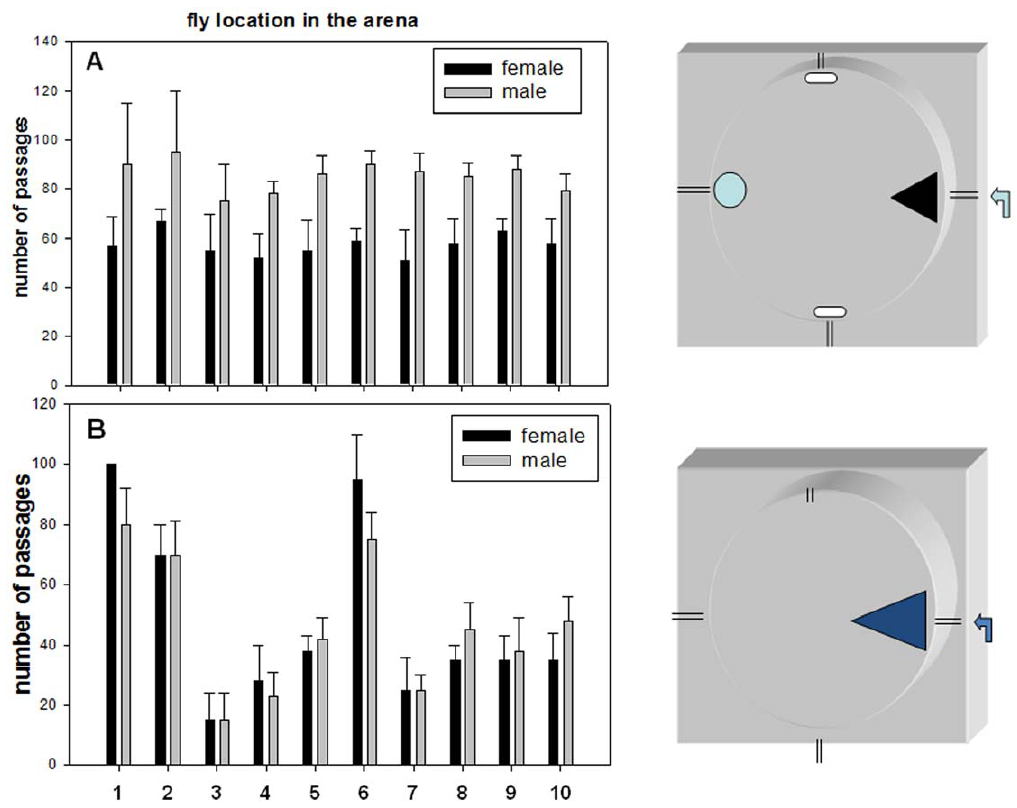
Figure 4. Comparison of the exploration characteristics between strains stimulated by a cocktail of aldehyde compounds. Five day old female and male flies were tested after two hours of starvation for their behavioral response using the arena/air pusher system and a cocktail of benzaldehyde/propionaldehyde/acetaldehyde at low concentrations (see Materials and Methods). The Y axis refers to the number of passages of individualflies in the four arenalandmarks asindicated in the drawings. Theexperimentandthemeasurementswere conductedin conditions where the flow of aldehyde compounds/air from the syringe creates a gradient in the arena. (A) For one series of experiments, the cumulative passages across the four landmarks were counted for a discontinuous period of ten minutes during which time the flies were active (discontinuous periods of time in which flies were immobilewere not counted).Numbers representtheaddition of three tested flies andbars representthe mean of five repeat experiments + / 2 S.E. (each repeat is the addition of three tested individual flies). (B) For another series of experiments, the passages in the blue triangle corresponding to the odor entry were counted. The discontinuous timing during which female Rover strain flies were active was measured for 100 passages. The average of ten Rover females was a time reference during which the other strains (female and male) were comparatively tested. The bars represent the mean + / 2 S.E. of five individual flies. 1, Rover; 2 Sitter; 3, Aldh-III* ; 4, CG11699* ; 5, CG11699** ; 6, CS , Canton S ; 7, CG11699*; for S ; 8, CG11699*; for R ; 9 , CG11699**; for S ; 10, CG11699**; for R . Mainly, the number of passages at the odor entry landmark gave: Rover, 100 (reference) and 80 + / 2 15 for female and male respectively; CS , 95 + / 2 18 and 80 + / 2 10; S , 70 + / 2 10 (female and male); CG11699* , 25 + / 2 15 and 20 + / 2 10; CG11699* ; for R , 30 + / 2 5 and 45 + / 2 10; CG11699* ; for S , 25 + / 2 10 and 25 + / 2 5. The statistical analysis using the Paired t -test was performed on the tested groups and is reported in table